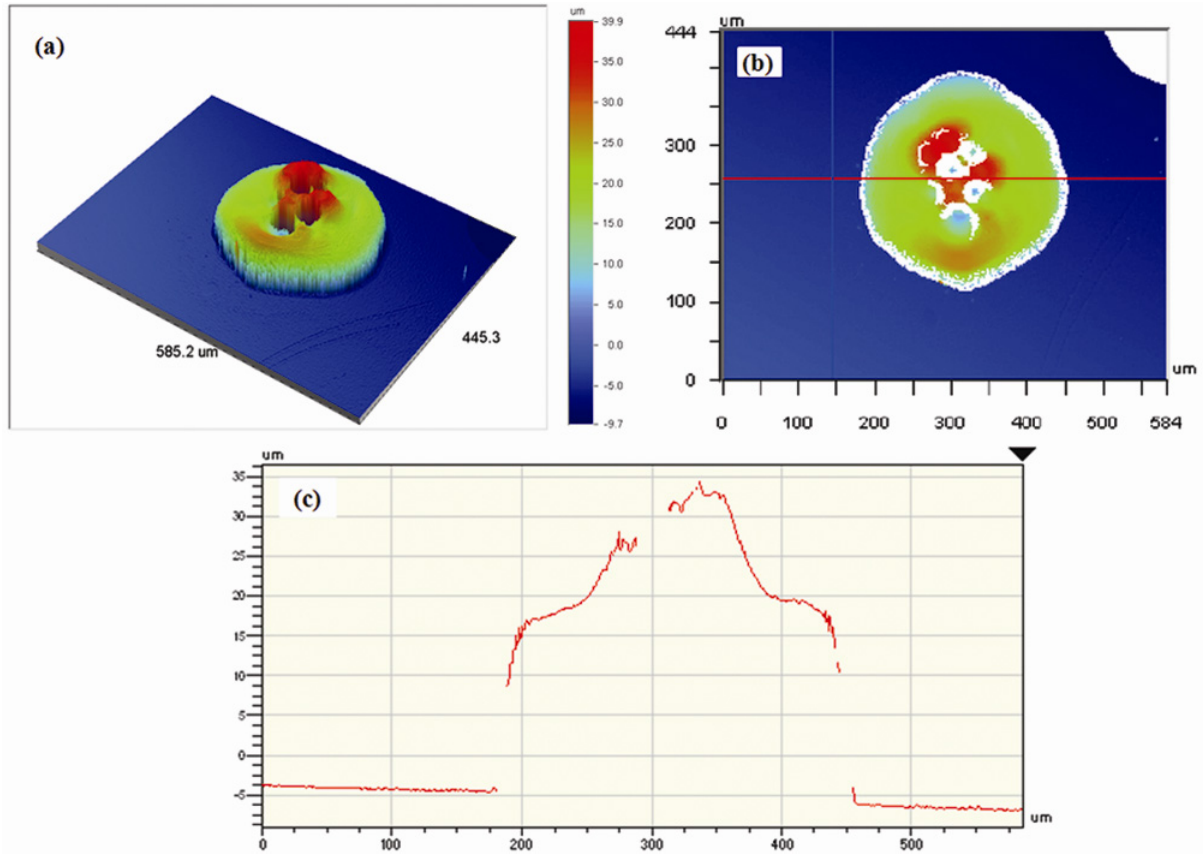
Figure 6. Splat scanned by WYKO surface profiler ( a ) 3D display; ( b ) top view and ( c ) cross section of splat.